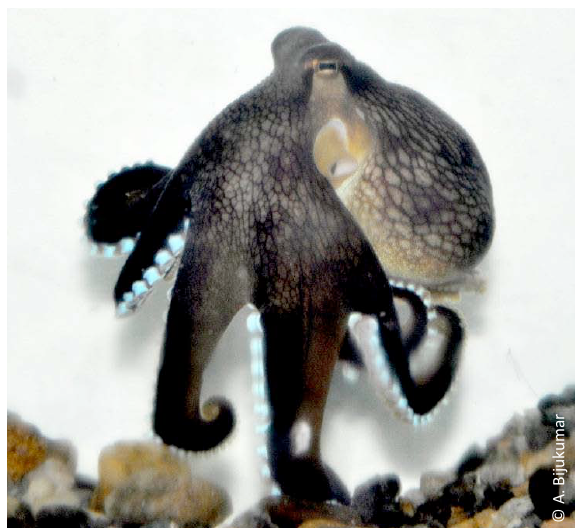
Image 2. A. marginatus (male) showing stilt walking